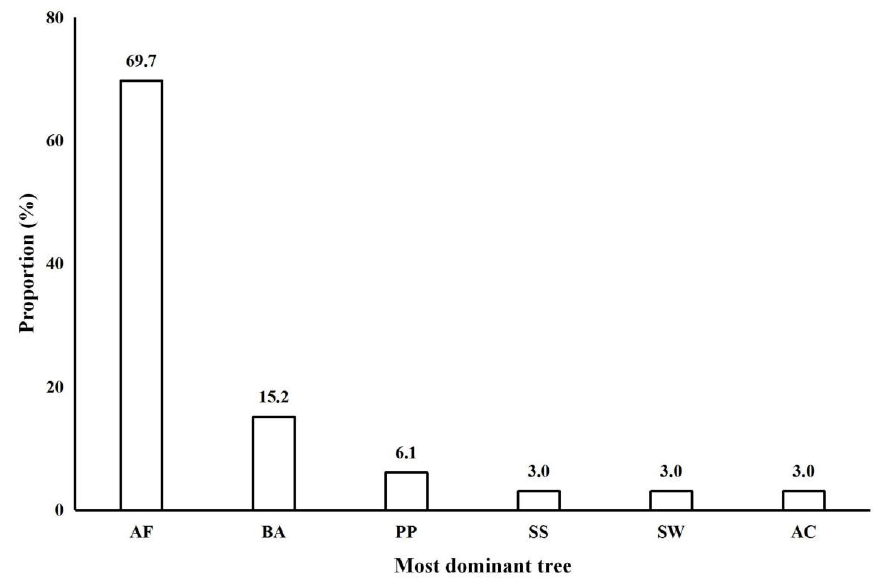
Figure 2. Composition of the most dominant trees in the Abies faxoniana plots (AF: Abies faxoniana; BA: Betula albosinensis; PP: Picea purpurea; SS: Sabina saltuaria; SW: Salix wallichiana; AC: Acer caudatum).